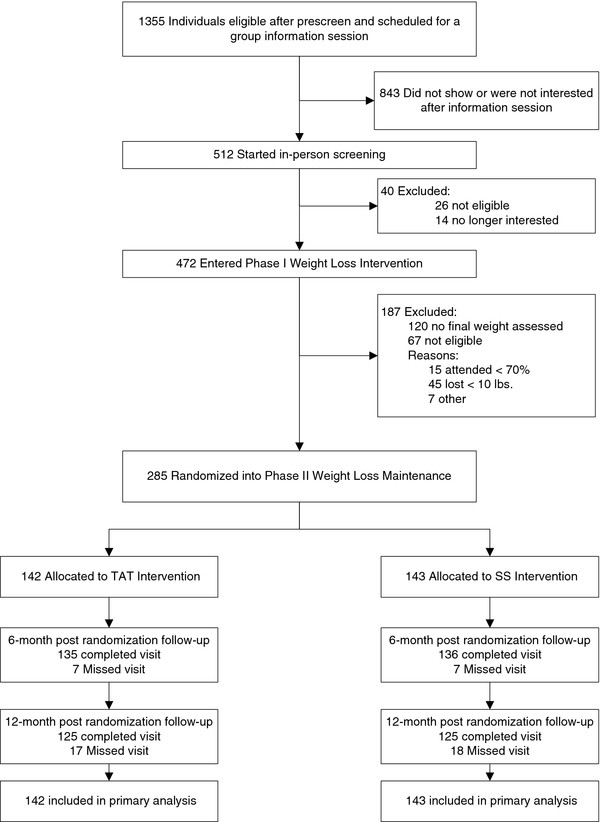
Flow of Study Participants.